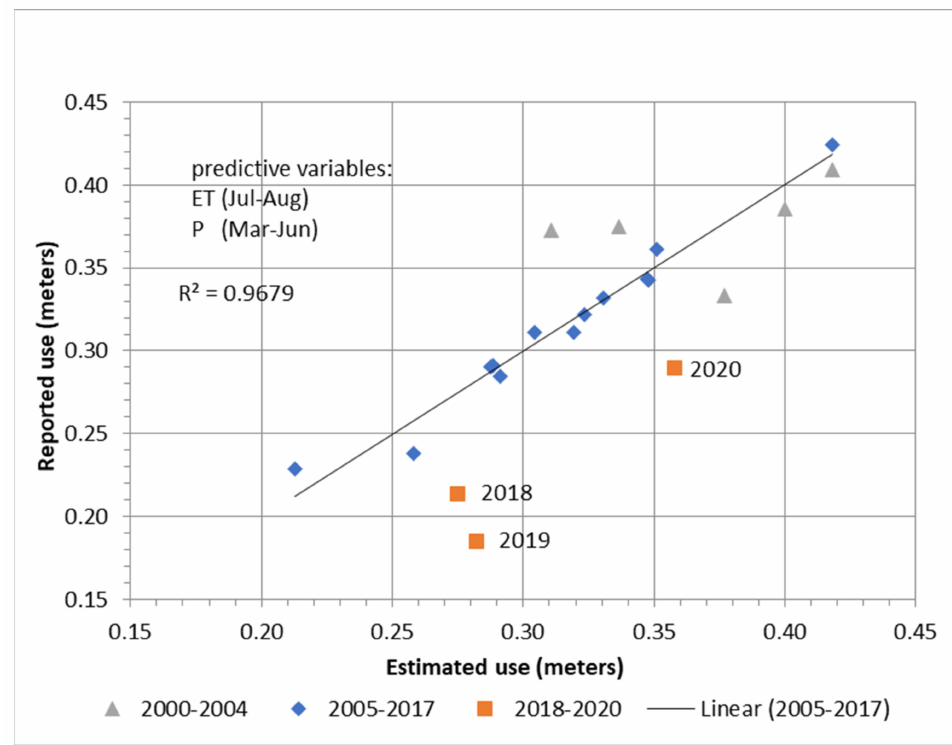
Figure 4. GMD No. 4 average reported and estimated water use per unit area for 2005–2017 (base period), 2000–2004, and 2018–2020. See Appendix A for methods.